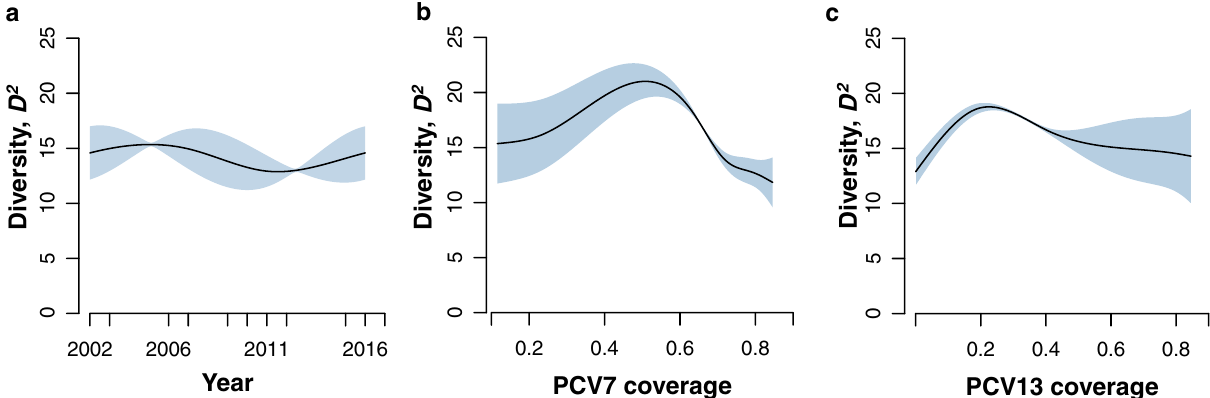
Figure 2. Impact of vaccination on pneumococcal serotype diversity. Partial plots resulting from the fit of a GAM model with three smooth terms to 2 D are shown. ( a ) Changes in 2 D according to year; ( b ) Changes 2 D according to smooth term PCV7 uptake; ( c ) Changes in 2 D according to smooth term PCV13 uptake. Smooth functions represent an assembly of polynomials joined together by knots. Each smooth term was significantly associated with 2 D (P < 2e-16 for each